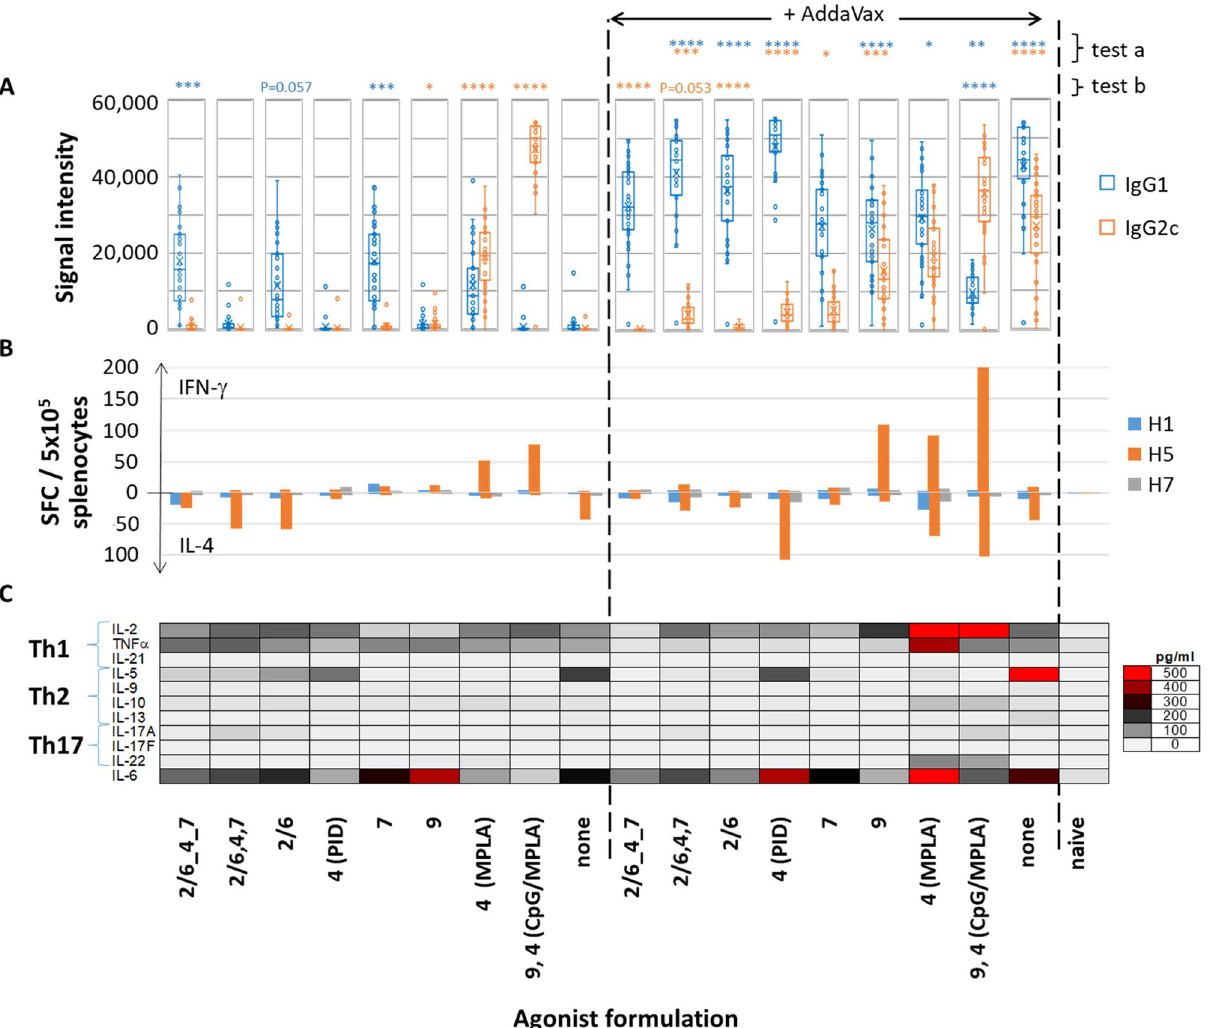
Figure 5. Th1 vs. Th2 balance in response to H5 vaccine formulated with different TLR agonists, with or without AddaVax. ( A ), Box plots of IgG1 and IgG2c profiles for H5 drift variants; each spot corresponds a different H5 variant on the microarray (geometric mean of 4 mice). Kruskal Wallis Dunn’s multiple comparison tests are shown above each column; test a, + AddaVax vs. − AddaVax; test b, left side, each TLR a/− AddaVax vs. no TLR a/− AddaVax; right side, each TLR a/+ AddaVax vs. no TLR a/AddaVax; ****P < 0.0001; ***P ≤ 0.001; **P ≤ 0.01; *P < 0.05 (colors correspond to IgG isotype). ( B ) Spot-forming cells (SFC) in IFN-γ and IL-4 ELISpots performed on the same mice as shown in ( A ) 10 days post i.p. boost on d56 (means of 4 mice), using H1, H5 and H7 as recall antigens. Cell viability confirmed using Con-A mitogen (not shown). ( C ) Multiplex cytokine bead array (LEGENDplex) of culture supernatants of ELISpots shown in ( B ). Other abbreviations, as Fig.